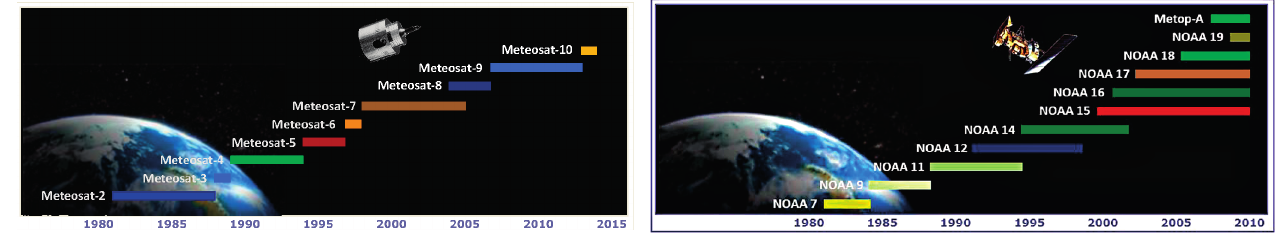
Figure 1 . ( Left ): Surface Solar Radiation Data Set—Heliosat (SARAH) temporal coverage by satellite. ( Right ): CM SAF cLoud, Albedo and RAdiation dataset from AVHRR data—edition 1 (CLARA-A1) temporal coverage by National Oceanic and Atmospheric Administration (NOAA) satellite number. Right panel figure with permission from